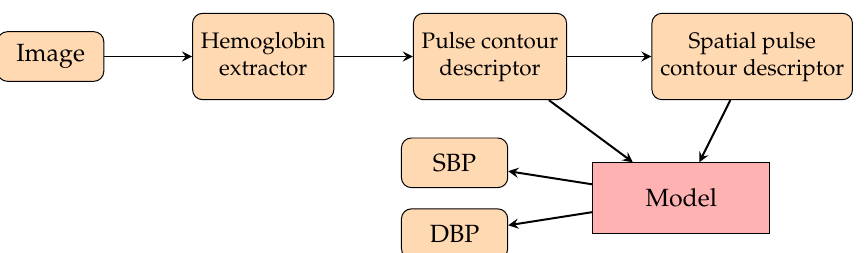
Figure 16. A pipeline of a deep learning model for rPPG signals proposed in [153]. On one hand, pixels from the ROIs of face images are extracted by CHROM as the rPPG signals. On the other hand, age and BMI are fed into another model selector to promote the model training to predict SBP and DBP.